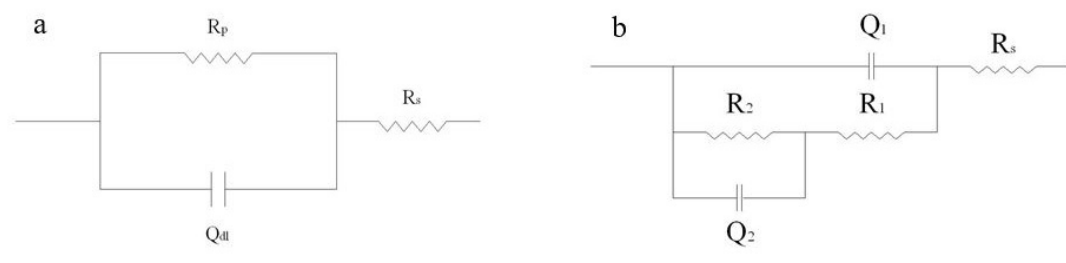
Figure 5. Equivalent circuit models used for fitting the Nyquist data. (a) one-time constant. (b) two-time constants. Table 2. Equivalent circuit parameters of the Ni coatings from the Nyquist